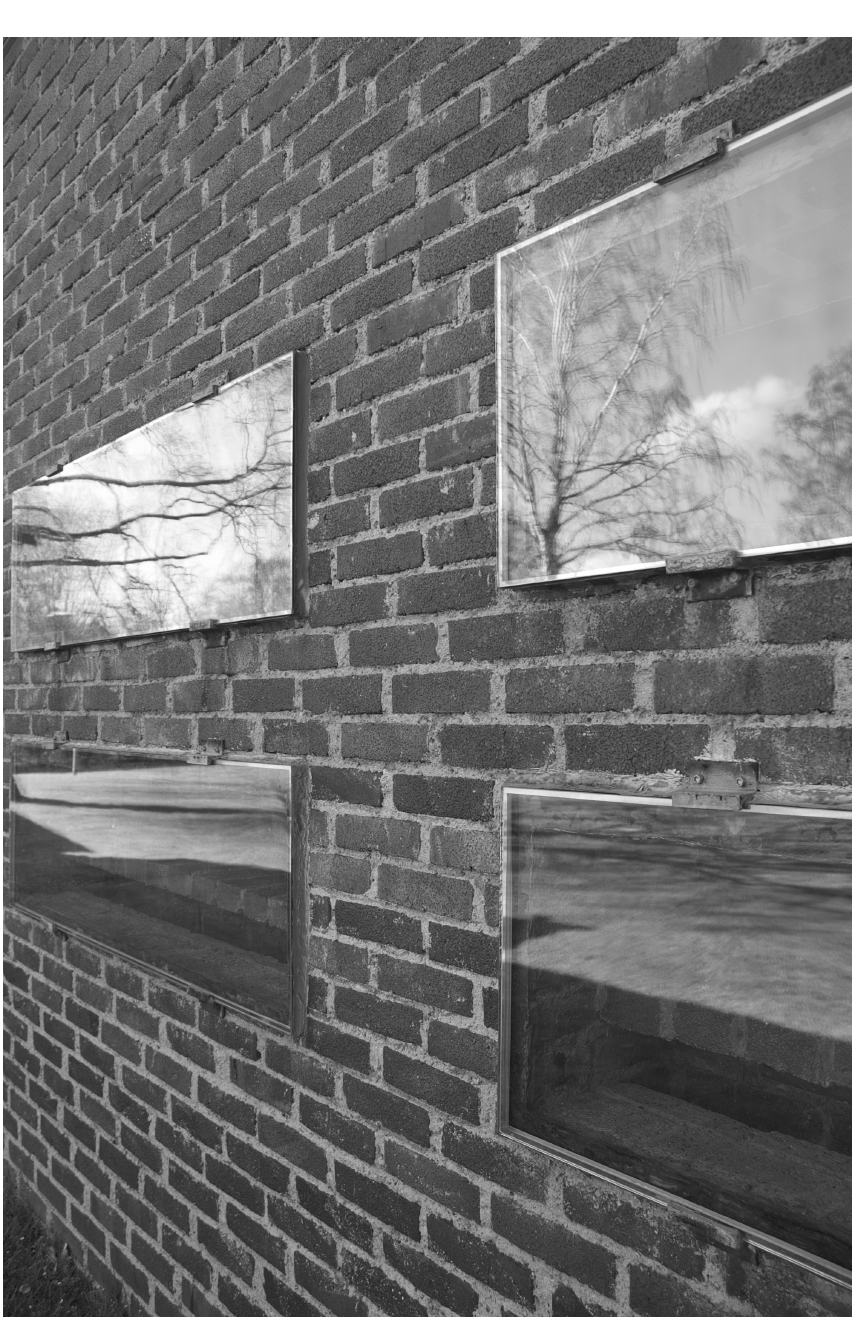
Figure 4: ‘From time to time this texture is relieved by another’ (p.